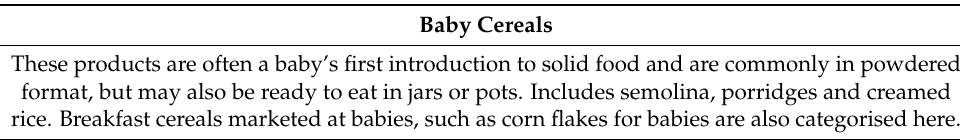
Table A1. “Baby food” categories as defined in the Mintel GNPD.